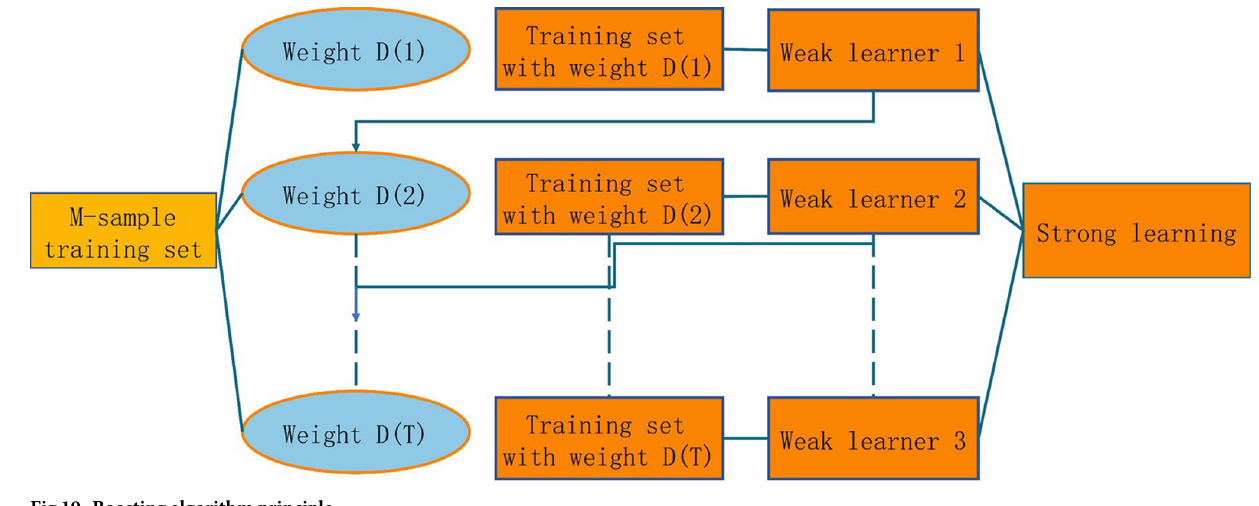
Fig 19. Boosting algorithm principle.